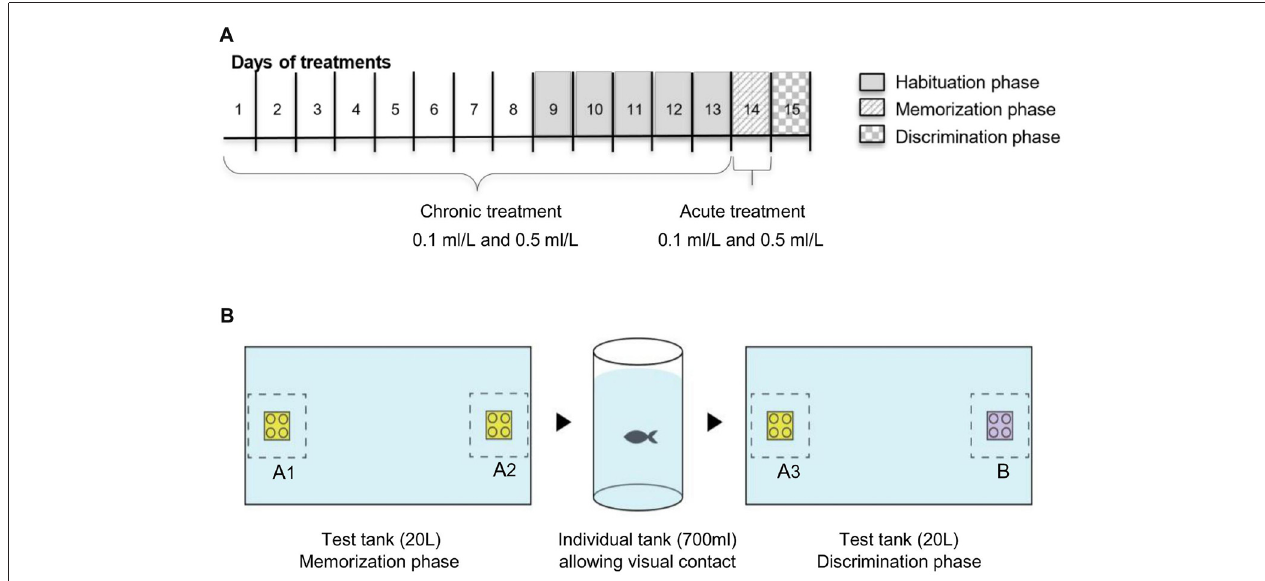
FIGURE 1 | Schematic representation of the experimental design: (A) timeline for Ayahuasca exposure and (B) one-trial discrimination test. Along the line, the 15 days of experiment. Five groups of Ayahuasca exposure were tested: chronic 0.1 ml/L, chronic 0.5 ml/L, acute 0.1 ml/L, acute 0.5 ml/L and 0.0 ml/L (control). One-trial discrimination test was split into three phases: 5 days of tank habituation, memorization phase (with two identical 3D objects—A 1 × A 2 ) and discrimination phase (with two different 3D objects—A 3 ×